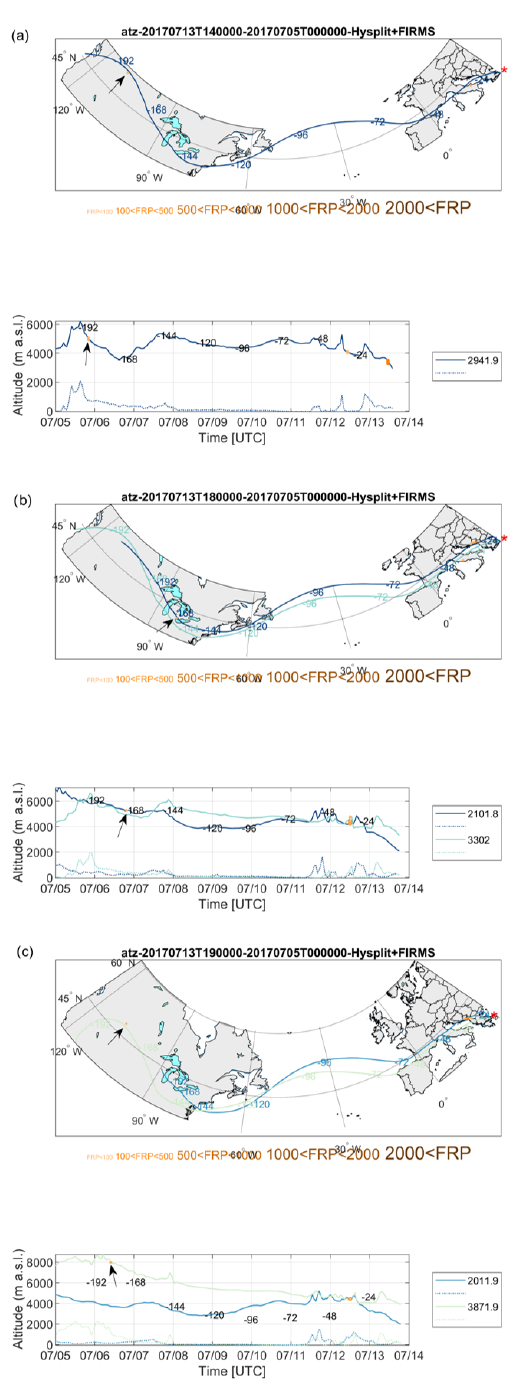
Figure 10. Back trajectories for layers shown in Fig. 9 for the Athens (“atz”) station. Layers in (a) and (b) are considered “mixed”, while the layer in (c) is considered “pure N America”. See text for more explanation. The fire location is marked with an arrow.